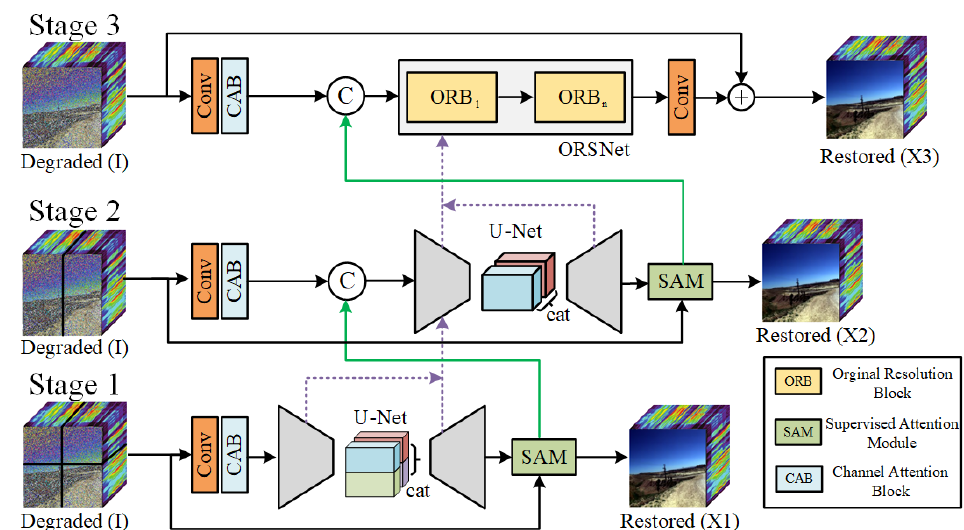
Figure 10. Schematic diagram of the network structure of MPRnet [62]. CBDNet: This is from a paper included in CVPR 2019, and it reached state-of-the-art (SOTA) performance on the DND dataset at that time. The model is more inclined to remove noise from real environments, and the whole network has two components, i.e., a noise estimation network and a non-blind denoising sub-network that removes noise with unknown noise levels. In this work, synthetic noisy images and real-world noisy images were both utilized to train the network; thus, the network was able to represent the noise in real-world images and improve the denoising performance. The network structure is shown in Figure 11.